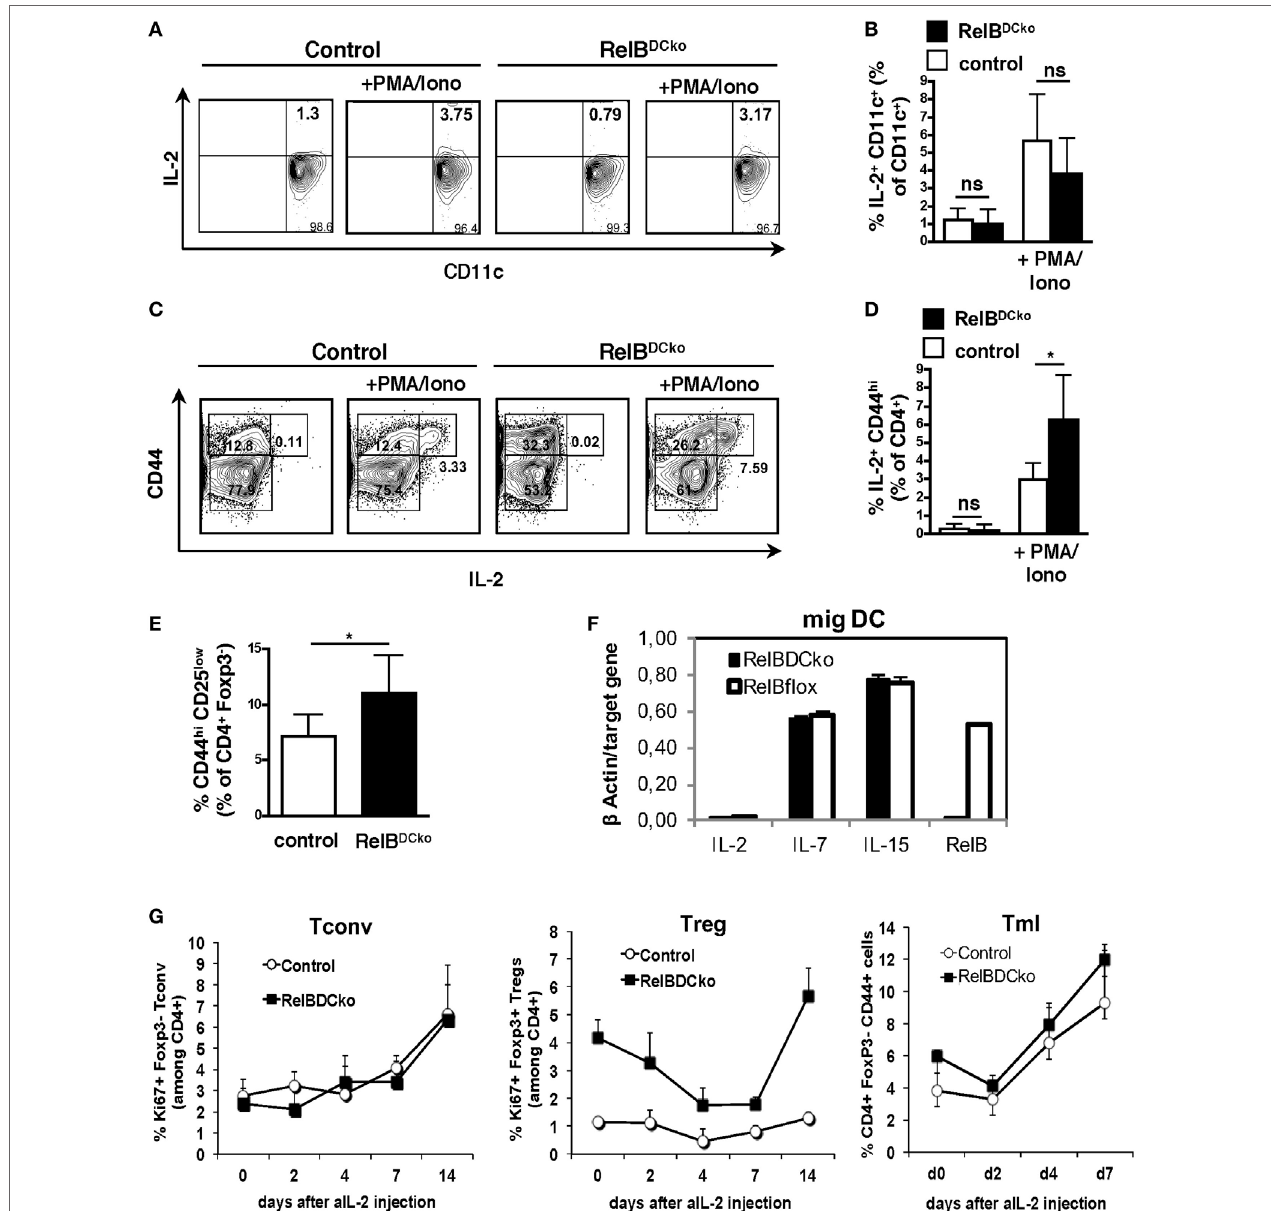
FigUre 5 | IL-2 produced by CD4 + CD25 int CD44 hi T cells is required for regulatory T cell (Treg) maintenance in RelB DCko mice. (a–D) Single cell suspensions from peripheral LN (PLN) of control and RelB DCko mice were either left unstimulated or activated with PMA/ionomycin for 5 h in the presence of brefeldin A. After incubation cells were stained (surface: CD11c, CD4, and CD44; intracellular: IL-2) and analyzed by flow cytometry. (a) Representative dot plots showing expression of CD11c and IL-2 among CD11c + dendritic cell (DC). Numbers in each quadrant indicate the percentages of cells gated on CD11c + cells. (B) Graphs display the percentages of IL-2 + CD11c + DC among CD11c + DC compiled from five independent experiments with one mouse per genotype and condition in each experiment. (c) Representative dot plots showing expression of CD44 and IL-2 among CD4 + T cells. Numbers in the quadrants indicate the percentages of cells gated on CD4 + cells. (D) Compiled date from percentages of IL-2 + CD44 + cells among CD4 + T cells of five independent experiments with one mouse per genotype and condition in each experiment are displayed. (e) Percentages of CD25 int CD44 hi cells among CD4 + T cells in PLN of control ( n = 6) and RelB DCko mice ( n = 7) from five independent experiments are shown. (F) mRNA expression of IL-2, IL-7, and IL-15 in sorted migratory CD40 hi DC from PLN of control and RelB DCko mice analyzed by qRT-PCR. (g) Injection of an IL-2 neutralizing antibody abrogated Treg but not conventional T cells (Tconv) cell division in RelB DCko mice. 1 mg α IL-2 antibody was injected intraperitoneal into RelB DCko and control mice. Before injection and 2, 4, 7, 14, and 21 days afterward blood samples were taken, stained for CD4, CD44, Foxp3, and Ki67, and analyzed by flow cytometry. Kinetics of the percentages of proliferating CD4 + Ki67 + Foxp3 − Tconv, CD4 + Ki67 + Foxp3 + Tregs, and CD4 + CD44 high Foxp3 − memory-like T cells after α IL-2 injection are shown in the diagram. Three mice per genotype and experiment were used. Depicted is one representative experiment from four experiments. (B,D,e,F) Data represent the mean values + SD. For statistical analyses student’s t -test was performed: ns, not significant, * p <